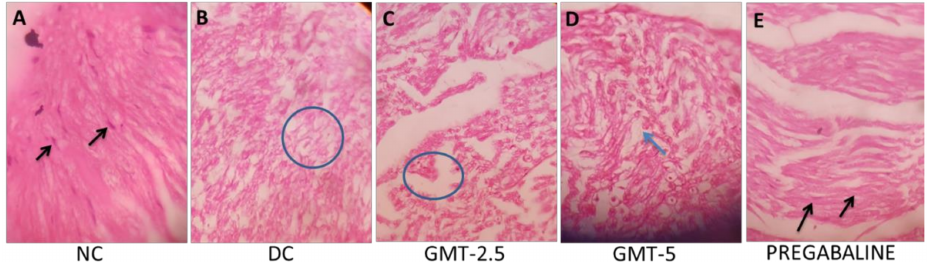
Figure 1. A hematoxylin and eosin section of sciatic nerve tissue ( A ) Control group treated with 0.5% CMC showing the normal arrangement of nerve fibers with elongated Schwann cells. ( B ) Diabetic control group showing axonal swelling. ( C ) Treated with GMT-2.5 showing axonal swelling of nerve fibers. ( D ) Treated with GMT-5 showing the mild derangements of nerve fibers. ( E ) Treated with pregabalin group showing uniformly arranged nerve fibers.